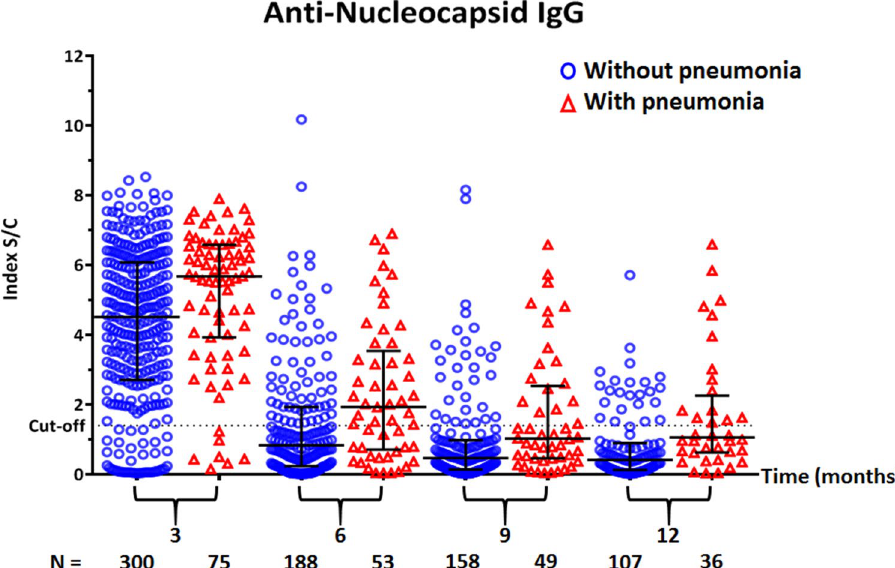
Figure 3. Scatter dot-plot with median and interquartile range (IQR) showing the distribution of anti- nucleocapsid IgG S/C index in serum samples of COVID-19 patients, stratified by disease severity. Red triangles and blue circles represent patients with and without pneumonia symptoms,